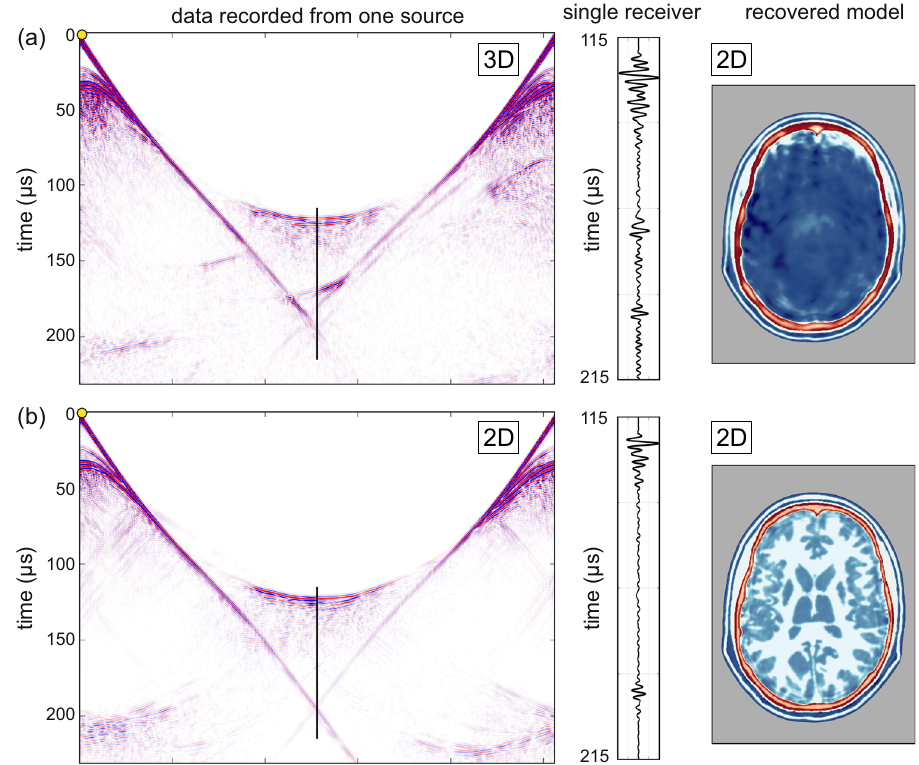
Fig. 5 Model recovery using two-dimensional FWI. a 3D data inverted using 2D FWI. b 2D data inverted using 2D FWI. Left panels show simulated data generated by a single source located at the yellow circle, as recorded on an elliptical array of 512 transducers placed around the head. Centre panels show data recorded by a single receiver located opposite the source; the position of the data shown is indicated by the blue line. Right panels show models recovered using purely two-dimensional FWI. Colour scale as shown in Fig.